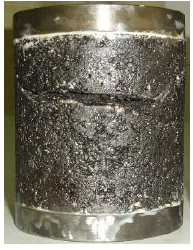
Figure 7. Tensile failure.